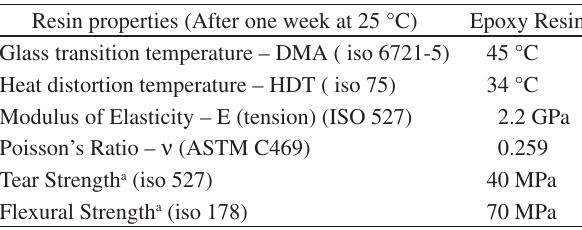
Table 1. Thermal and mechanical properties of epoxy resin.